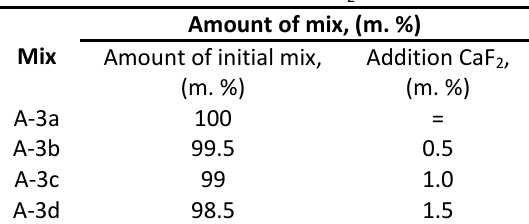
Table 4. Composition of raw mixes with addition CaF 2